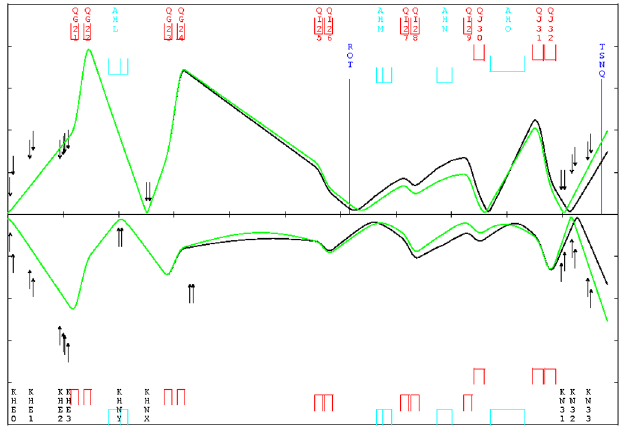
FIG. 5. 2 σ beam envelope from target E to the SINQ target calculated with TRANSPORT. Arrows represent collimators. For more details see